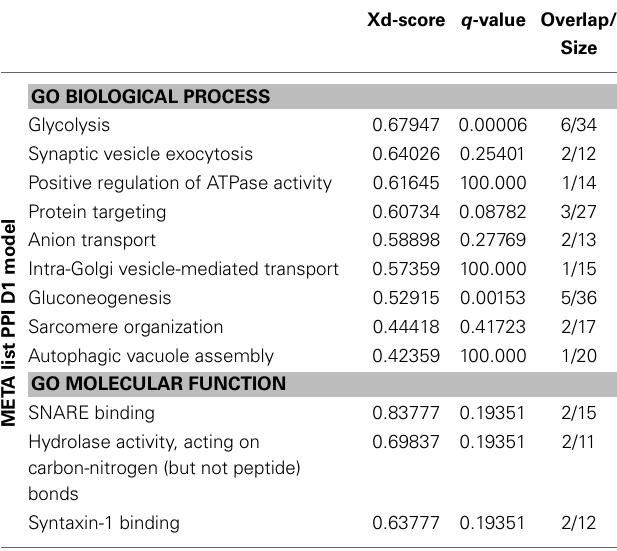
Table 3 | Summary table of most significant results of the Jepetto analysis of META list, PPI D1